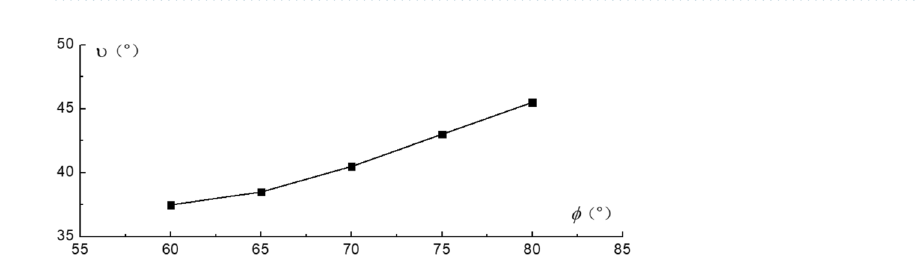
Figure 11. Curves for dip angles of failure surface vs dip angles of slope surface.